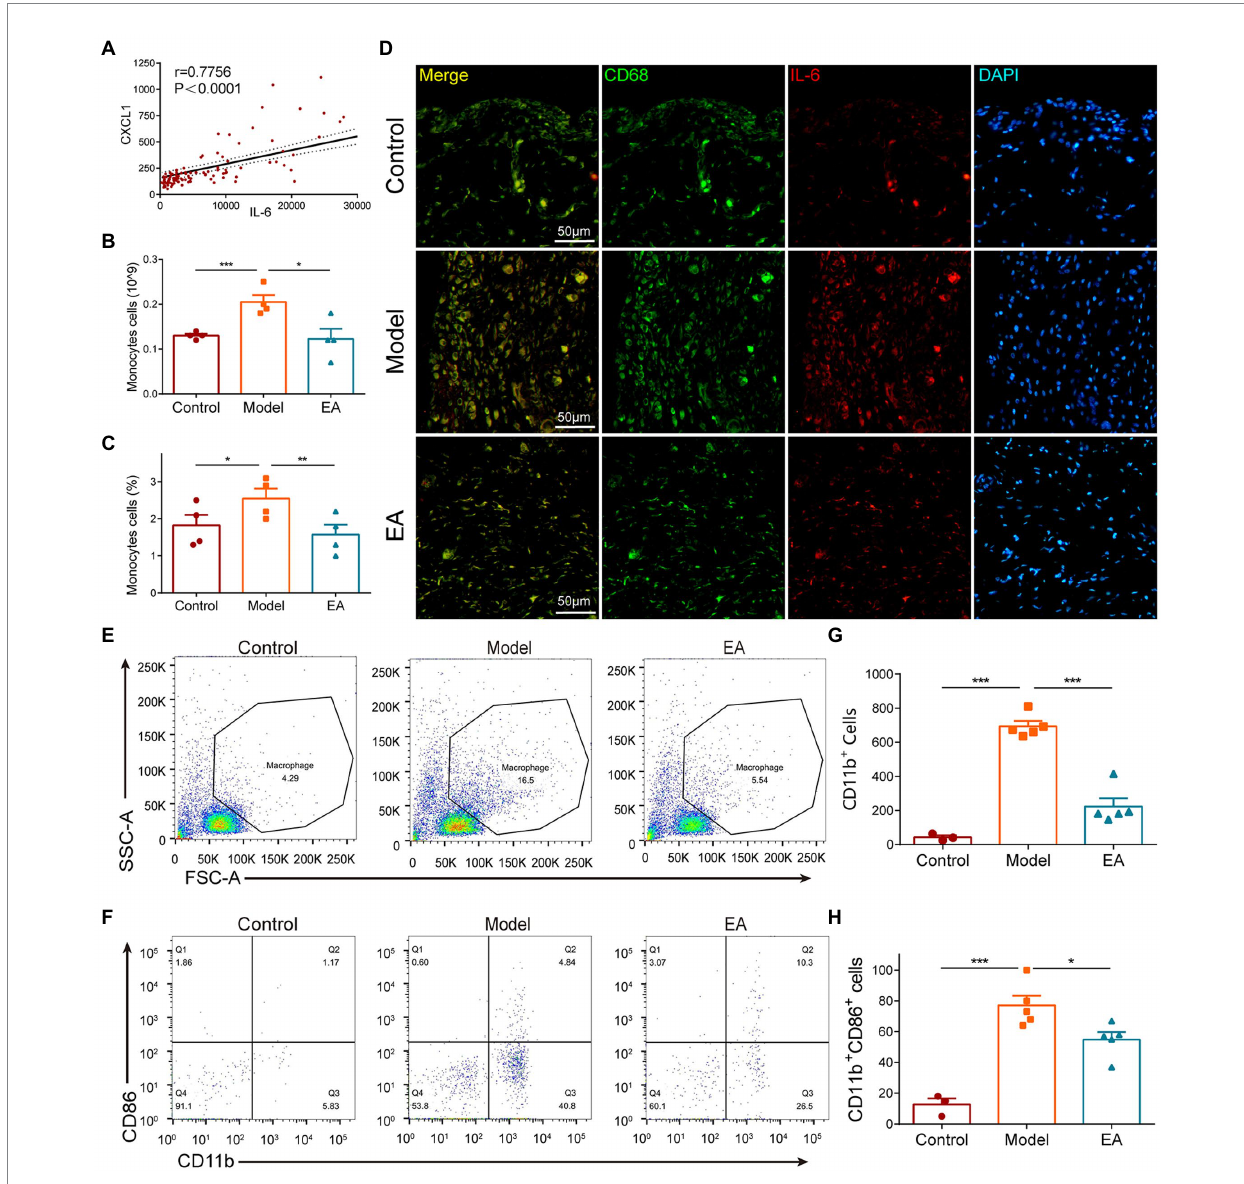
FIGURE 6 EA inhibited the CXCL1-dependent overexpression of IL-6 in macrophages of the synovium. (A) All groups except the control group exhibited a positive correlation between the levels of CXCL1 and IL-6 in the synovium (data not shown). (B) The number of circulating monocytes was increased in the model group but decreased in the EA group. (C) The percentage of circulating monocytes increased in the model group but decreased in the EA group. (D) The co-expression of IL-6 and CD68 + macrophage was increased in the synovium in the model group but decreased in the EA group. (E–H) In Flow Analysis, the number of CD11b + CD86 + M1 macrophages in the synovium was increased in the model group but decreased in the EA group. ( n = 5, * p < 0.05, ** p < 0.01, *** p <